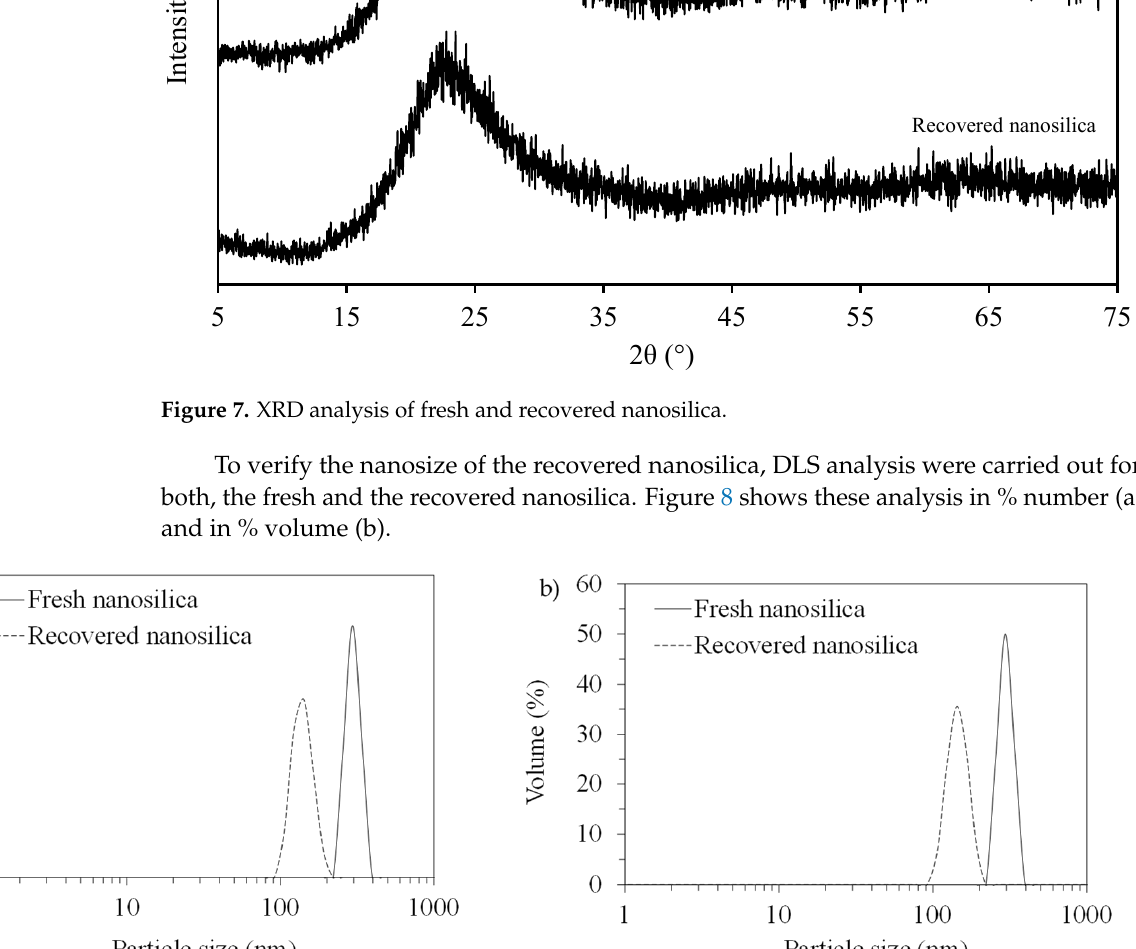
Figure 7. XRD analysis of fresh and recovered nanosilica.